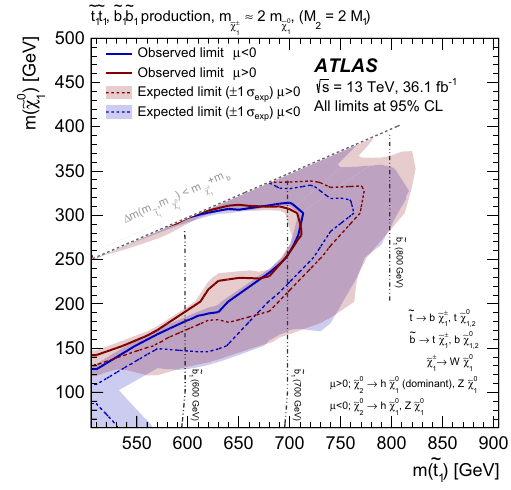
Fig. 11 Exclusioncontour as afunction of m ˜ t and m ˜ χ 0 inthepMSSM 1 1 model described in the text. Pair production of ˜ t 1 and ˜ b 1 are considered. Limits are set for both the positive (red in the figure) and negative (blue in the figure) values of μ . The dashed and dotted grey lines indicate constant values of the ˜ b 1 mass. The signal models included within the shown contours are excluded at 95% CL. The dashed lines and the shaded band are the expected limit and its ± 1 σ uncertainty. The thick solid line is the observed limit for the central value of the signal cross- section. The expected and observed limits do not include the effect